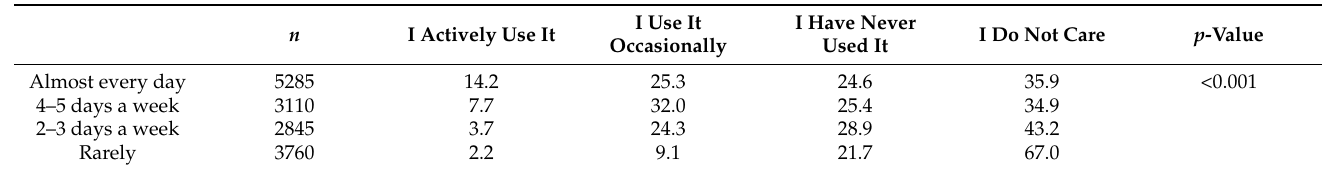
Table 3. The relationship between frequency of a well-balanced diet and prevalence of mineral- fortified food usage.